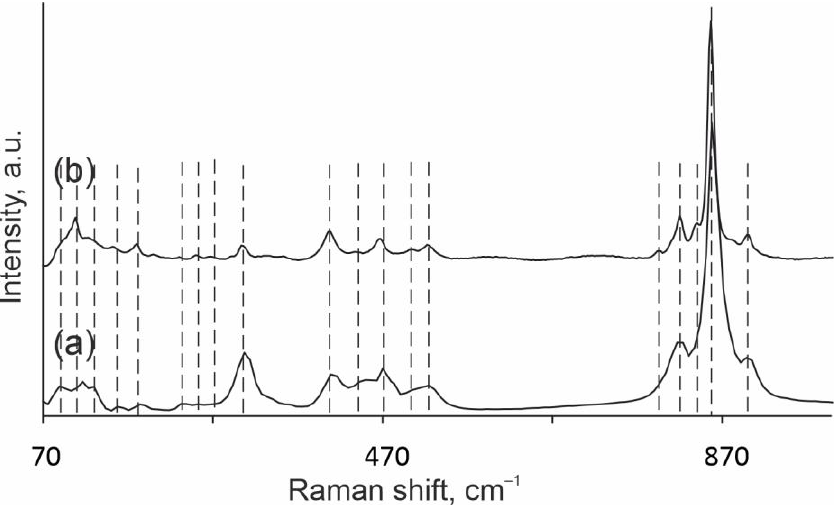
Figure 4. Raman spectra of BaAs 2 Zn 2 O 8 at 175 ◦ C, obtained during in situ high-temperature Raman experiment (a) and at 27 ◦ C from the crystal, which has been studied by high-temperature SCXRD